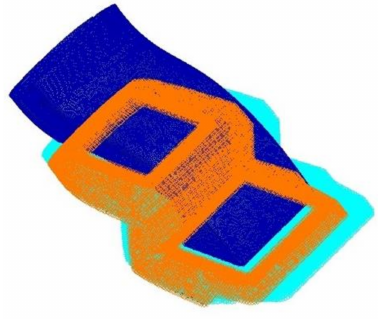
Figure 8. Boundary condition of S-duct.